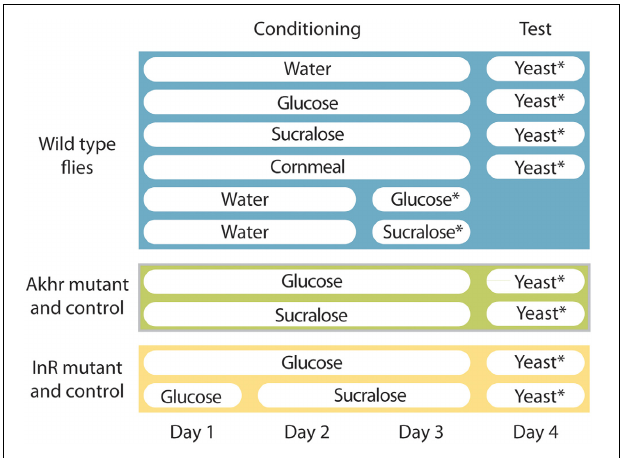
FIGURE 1 | Overview of the experimental design. Asterisks indicate when food consumption was measured. mated males over 24 h. Nine to eleven flies were used for each test ( Figure 1